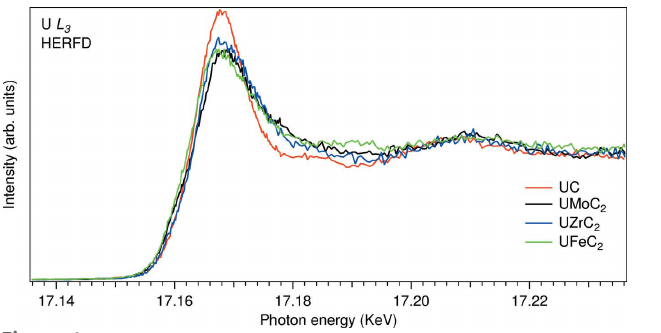
Figure 4 U L 3 HERFD-XAS spectra of uranium carbides.